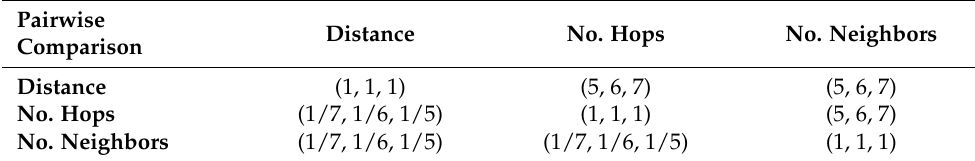
Table 5. Pairwise comparison matrix of criteria as TFNs.